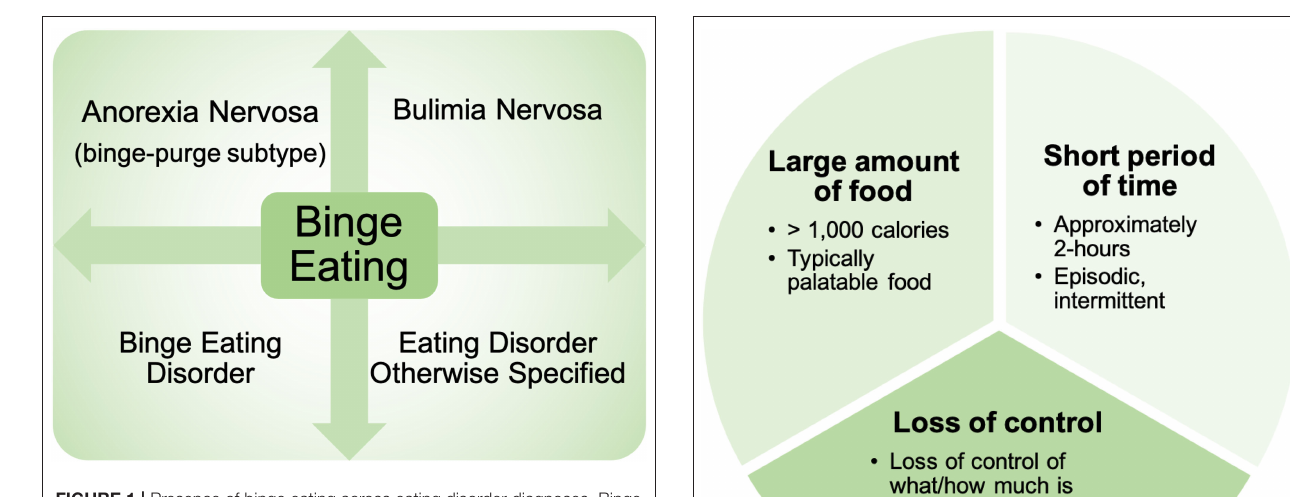
FIGURE 1 | Presence of binge eating across eating disorder diagnoses. Binge eating is present across nearly all eating disorder diagnoses currently in the Diagnostic and Statistical Manual of Mental Health Disorders − 5th Edition. Diagnoses include: binge eating disorder, bulimia nervosa, anorexia nervosa binge-purge subtype, as well as eating disorders otherwise specified.